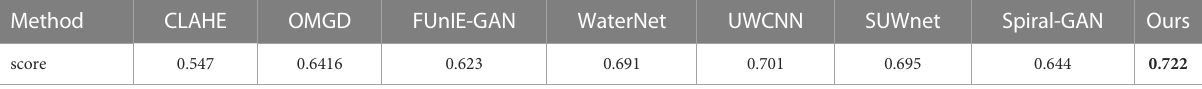
The bold indicates the best scores.